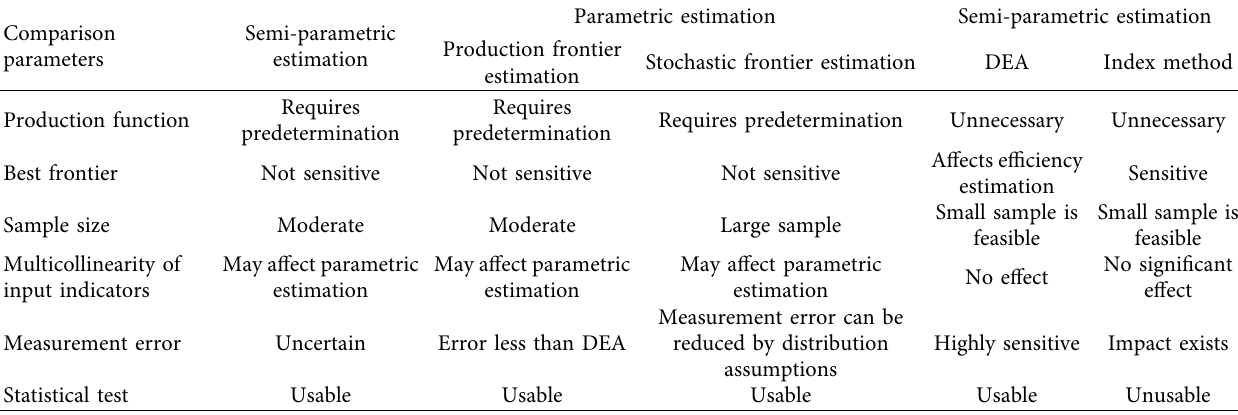
Figure 1: Te category of efciency. Note that the source is from Bosca et al. [2], Eberhardt [3], Grosskopf and Margaritis [4], See and Li [5], and Yang [6]. Table 1: Comparison of parameters of efciency measurement methods.